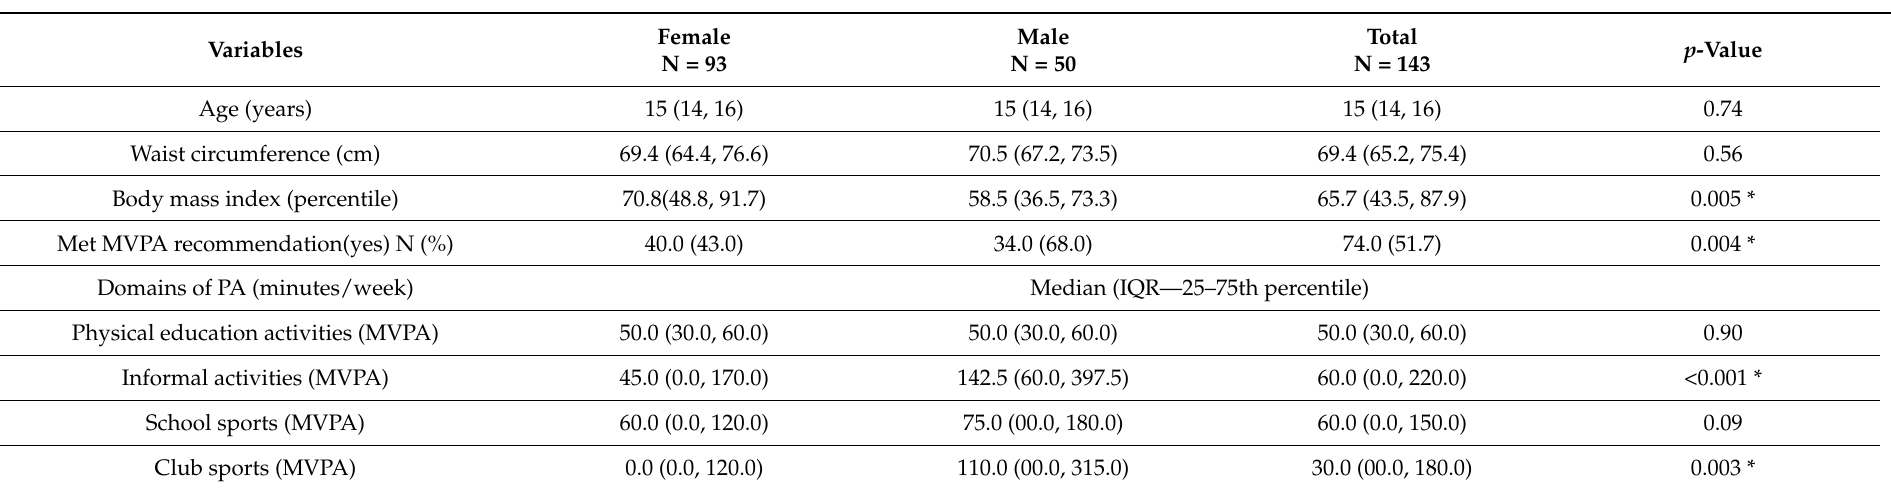
Table 2. Overall and specific study condition sample characteristics categorized by